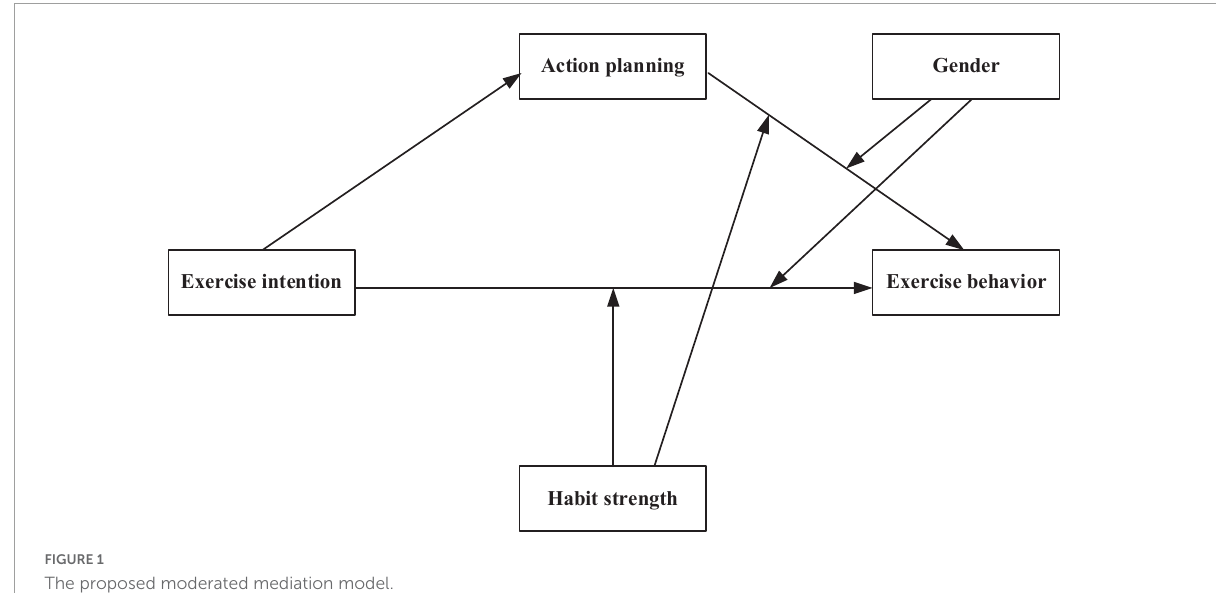
FIGURE1 The proposed moderated mediation model.